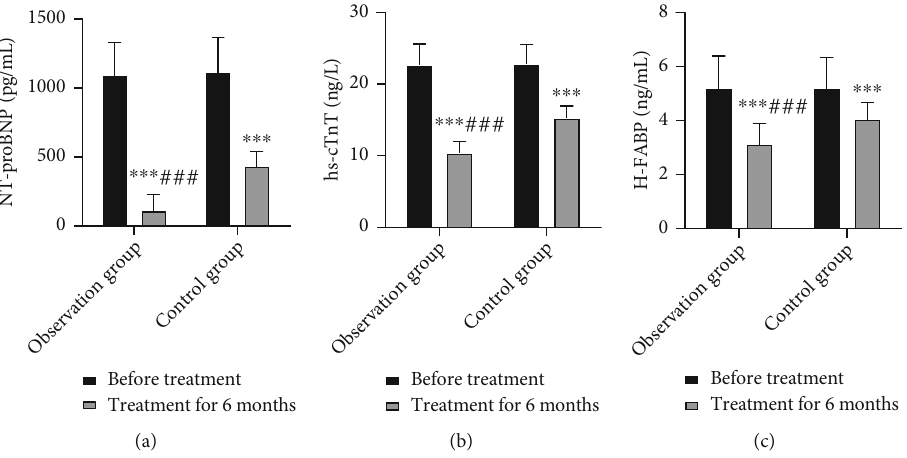
Figure 5: Comparison of myocardial injury markers in both groups. (a) NT-proBNP levels; (b) hs-cTnT levels; (c) H-FABP levels. Compared with pretreatment, ∗∗∗ P < 0 : 001 ; compared with the control group, ### P < 0 : 001 . Table 3: Comparison of 6-minute walking distance of both groups ( (cid:1) x ± s , m). Grouping